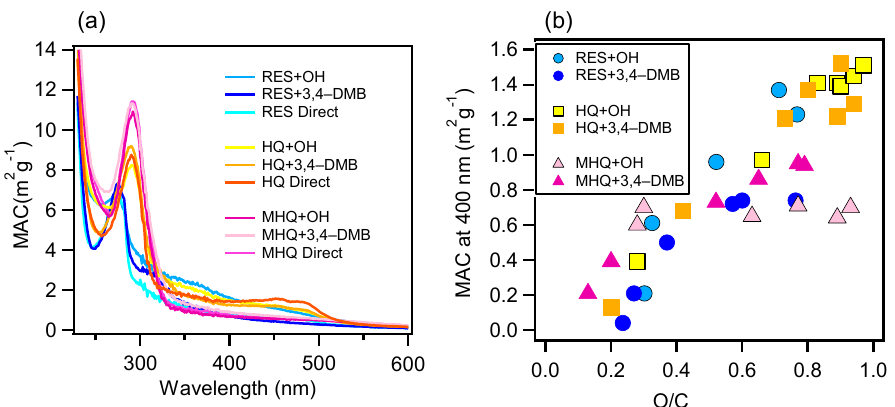
Figure 3. ( a ) Mass absorption coefficient (MAC) values as a function of the wavelength of the final solutions and ( b ) MAC values at 400 nm versus the oxygen-to-carbon (O/C) ratios of the solutions during different times of the OH- and 3 C*-mediated oxidation experiments.